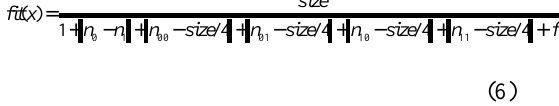
Fig. 3. The syntax rules of GP